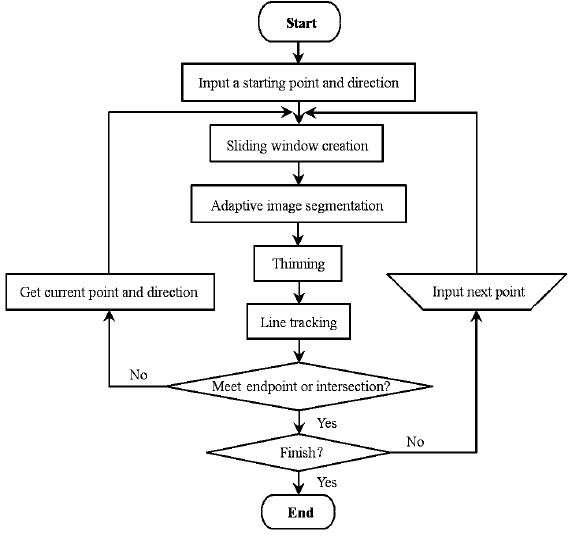
Figure 2. The procedure of linear feature